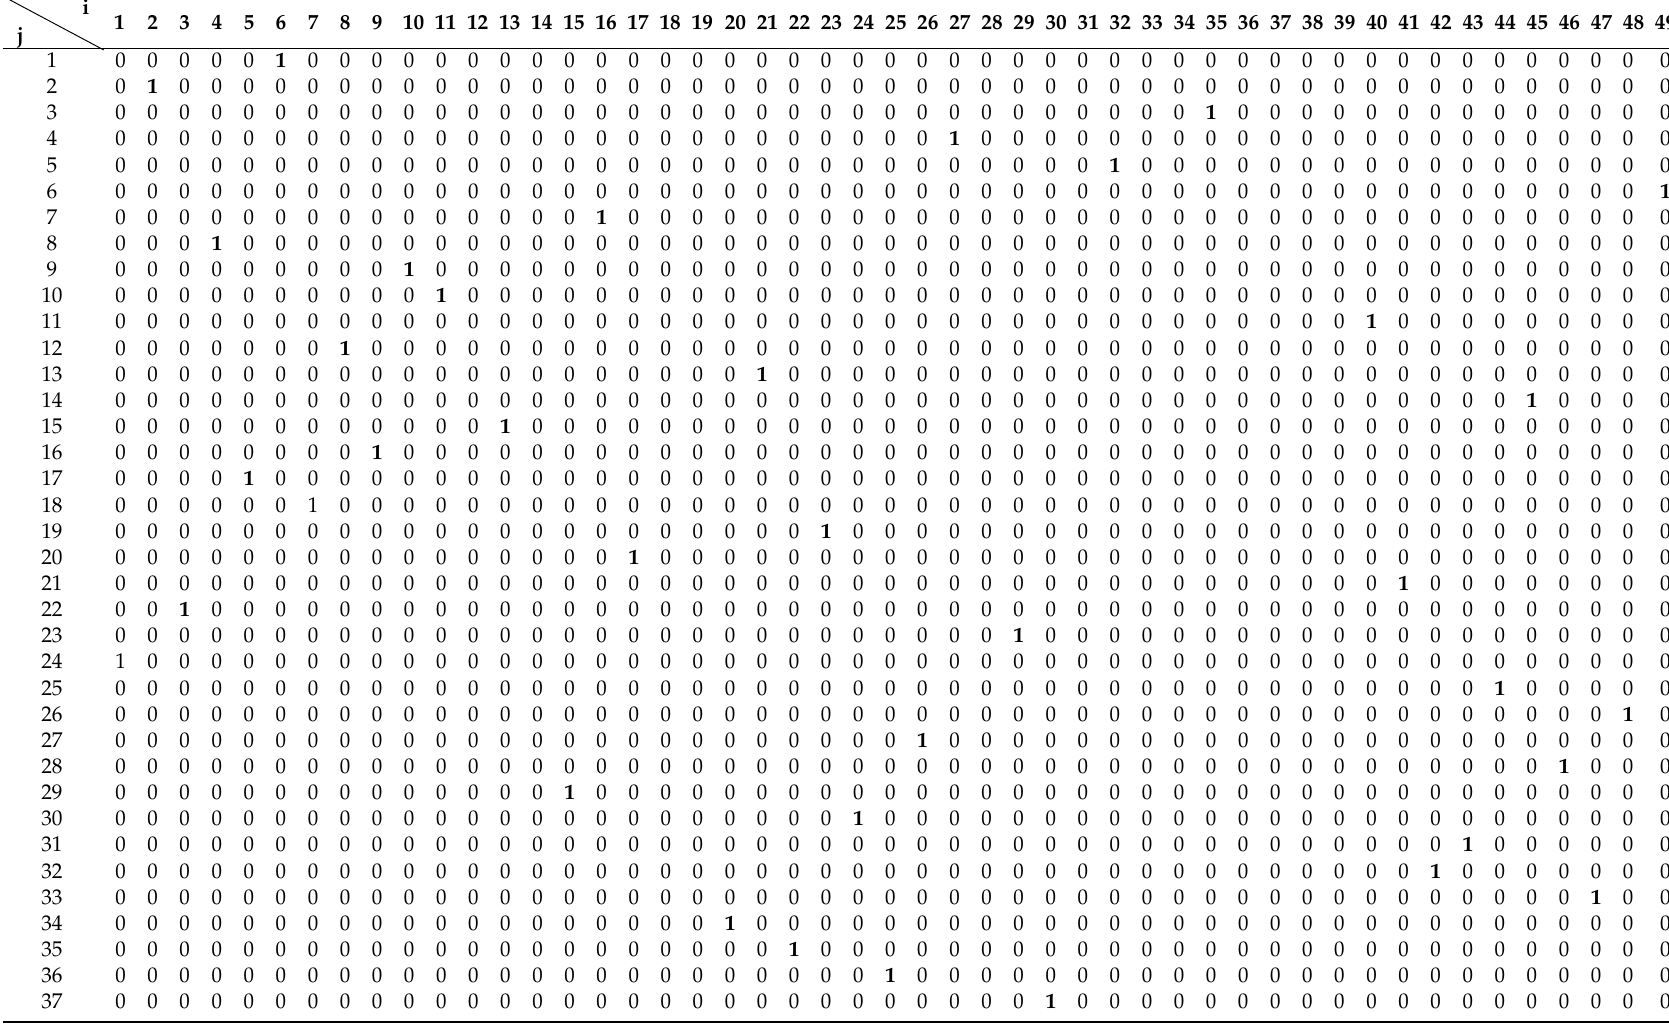
Table 14. Optimal